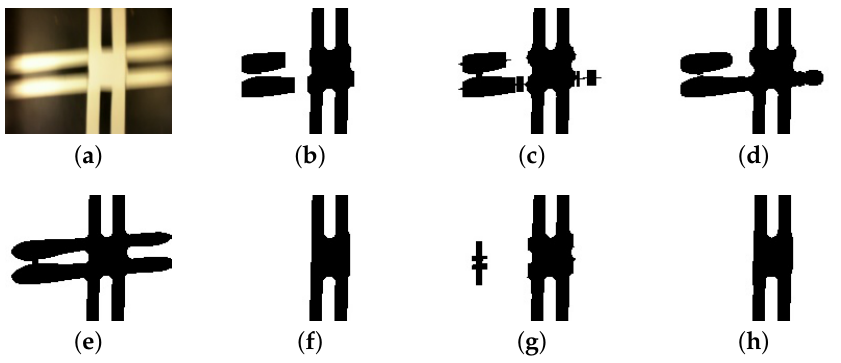
Figure 11. Comparison of different kernel shapes and sizes and its impact on crossing noise elimination. ( a ) original image; ( b ) rectangular Kernel size: 15 × 10; ( c ) cross-shaped Kernel size: 15 × 10; ( d ) elliptical Kernel size: 15 × 10; ( e ) original image binarization; ( f ) rectangular Kernel size: 30 × 10; ( g ) cross-shaped Kernel size: 30 × 10; ( h ) elliptical Kernel size: 30 ×